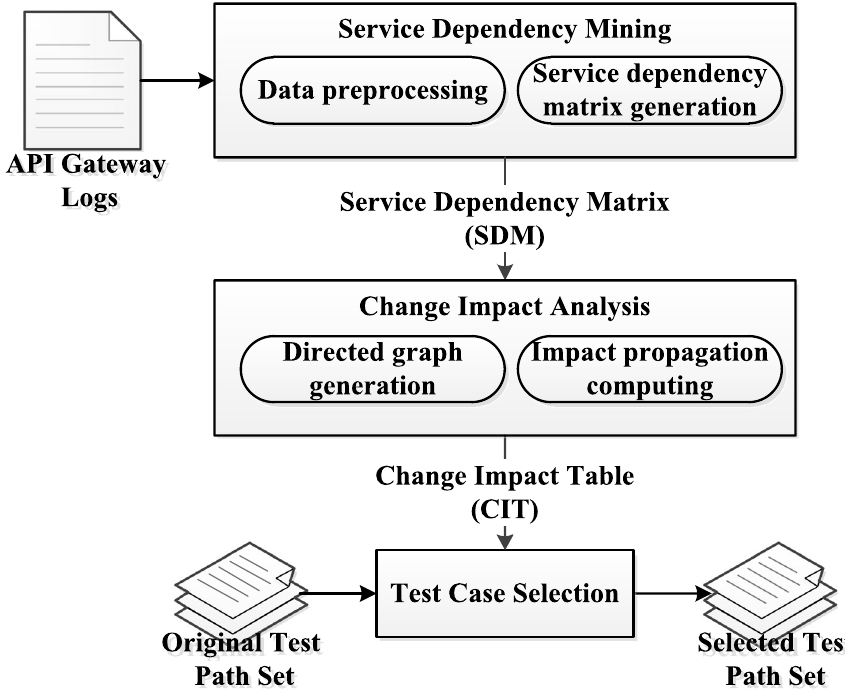
Fig. 1 Flowchart of